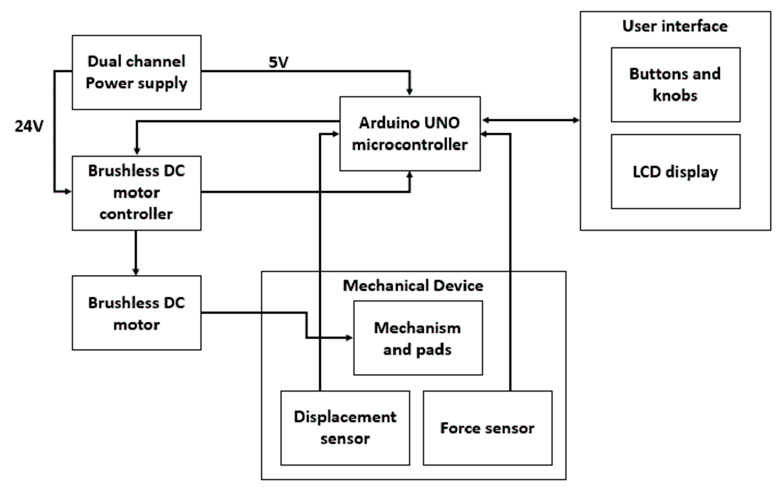
Figure 13. Block diagram of the knee-loading device.